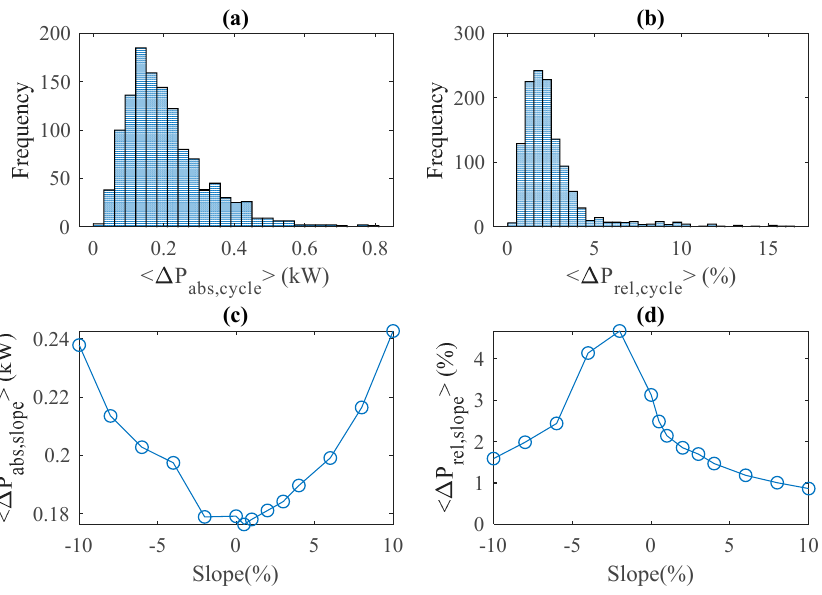
(cid:68) (cid:69) ∆ P and abs , c